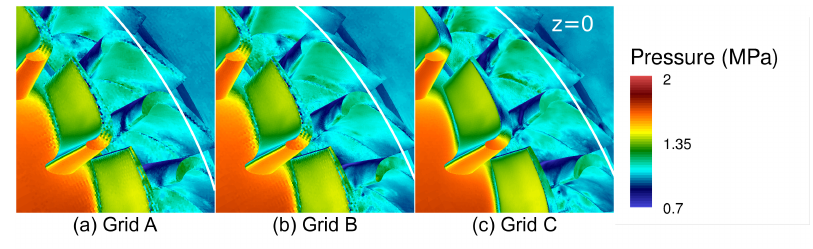
Figure 8. Instantaneous pressure contours at the walls near z = 0 for: ( a ) Grid A; ( b ) Grid B; and ( c ) Grid C.